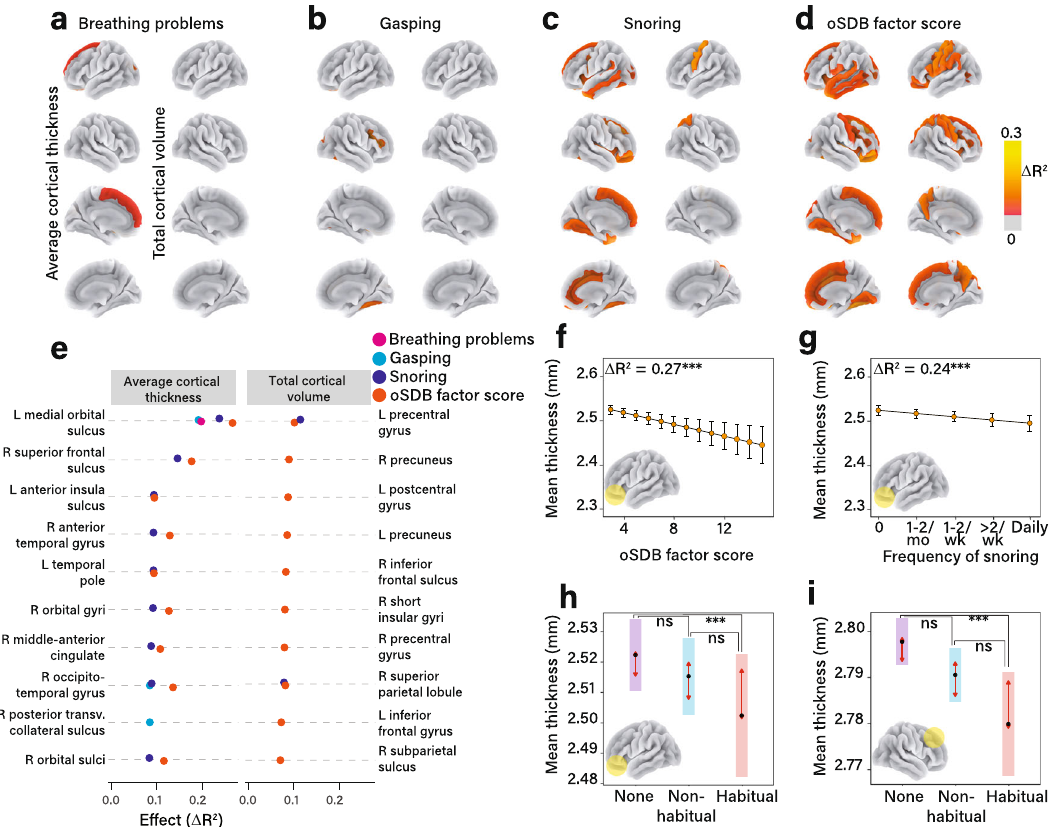
Fig. 3 Obstructive sleep disordered breathing (oSDB) is associated with regional cortical thinning. a – d Atlas-based effect size maps projected on a cortical surface demonstrate the relationship between the frequencies of individual symptoms, the total oSDB factor score and cortical morphometric variables (average cortical thickness (left) and total volume (right)) measured using magnetic resonance imaging (MRI). Among the individual symptoms, the greatest effect size was identi fi ed for the relationship between the frequency of snoring and average cortical thickness ( c ). The top ten cortical regions of interest (ROI) wherein the strongest effects were identi fi ed for each morphometric variable are shown in e . Effect sizes were calculated by measuring the change in overall proportion of variance by adding the predictor to the covariates-only model comprising age, sex, race/ethnicity, and household income as fi xed effects and MRI scanner as a random effect. f The covariate-adjusted model for the relationship between oSDB factor score and the mean cortical thickness within the left medial orbital sulcus in 10,140 children. This relationship was replicated for the frequency of snoring as a predictor ( g ). The error bars in f , g span 95% con fi dence intervals around the estimated marginal mean cortical thickness. h shows a potential threshold associated with cortical thinning within the left medial orbital sulcus with pairwise comparisons between 661 children who snored habitually (>2 nights a week), and 6040 children who did not snore. However, there was no signi fi cant difference between 3439 children who snored non-habitually, de fi ned as less than three nights a week, compared to the non-snoring children. i A similar comparison for the average thickness of the right superior frontal sulcus. A P value threshold of 0.05 was applied to all effect size maps following correction for false discovery. All pairwise comparisons in h and i were adjusted for multiplicity using the Tukey method with the arrows on either side of the estimated mean highlighting the regions of overlap of the estimated marginal means. These tests were two-sided. Cortical surface area was not associated with oSDB or any of the individual symptoms. Source data are provided as a source data fi